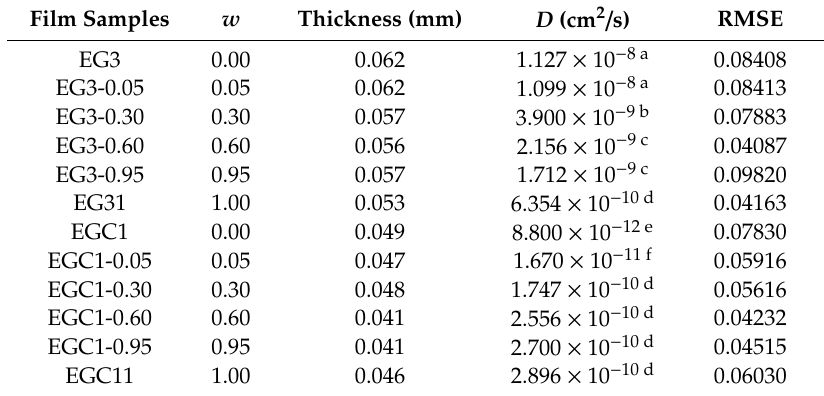
Table 6. Di ff usion coe ffi cients of one-way release of CEOs from films to aqueous ethanol at 4 ◦